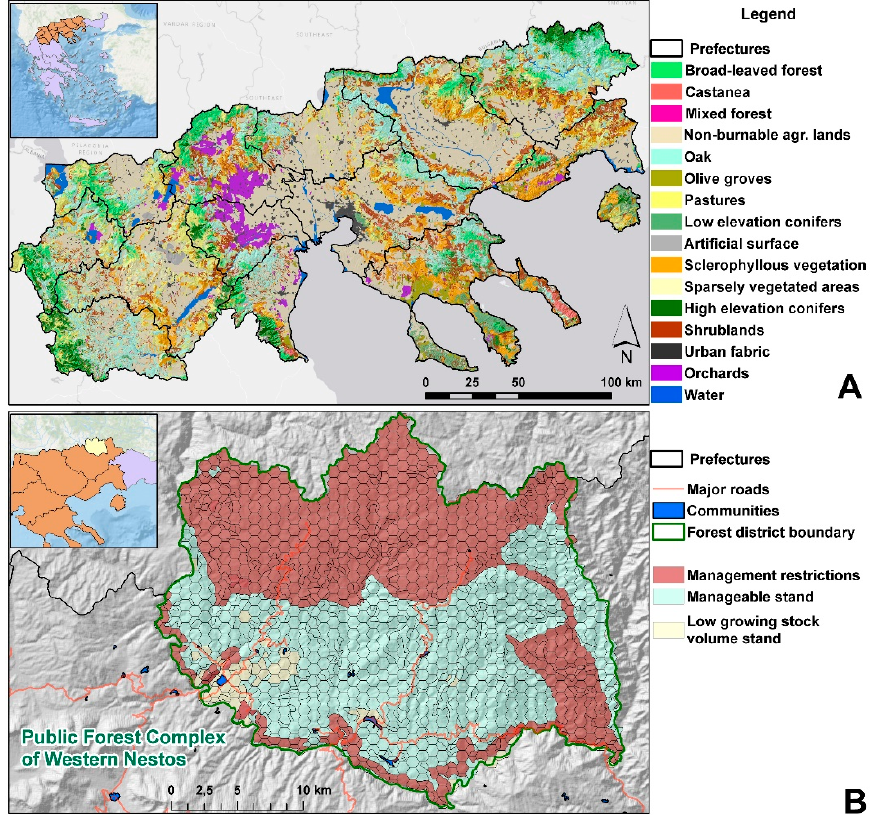
Figure 1. ( A ) The dominant land cover types in Macedonia, Greece. ( B ) The forest district of Western Nestos, with each hexcell symbolized by growing stock volume and management